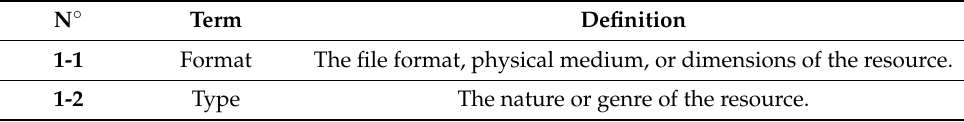
Table A2. File -related DC